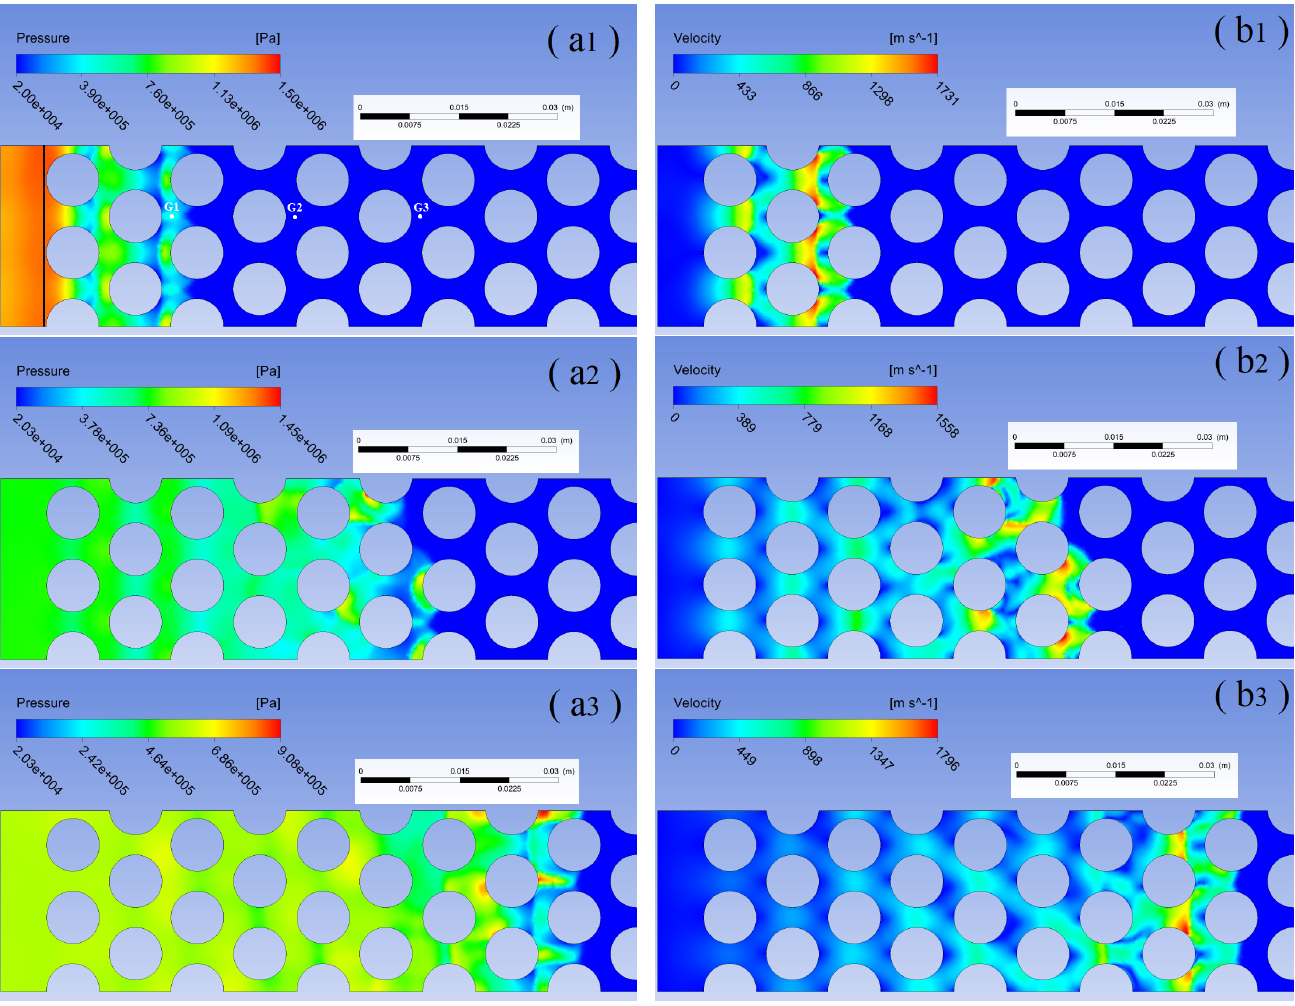
Figure 3. Simulated profiles of pressure and velocity magnitude in the center plane between the side walls at times: t 1 = 1.81 × 10 − 5 s, t 2 = 5.18 × 10 − 5 s, and t 3 = 7.70 × 10 − 5 s corresponding to the three rows: ( a1 – a3 )—pressure; ( b1 – b3 )— velocity magnitude. In ( a1 ), the vertical line at x = 6 mm indicates the initial position of the boundary of the high-pressure driving section. The points G 1, G 2, and G 3 in ( a1 ) indicate the positions where we measure the pressure record in time, which is shown in Figure